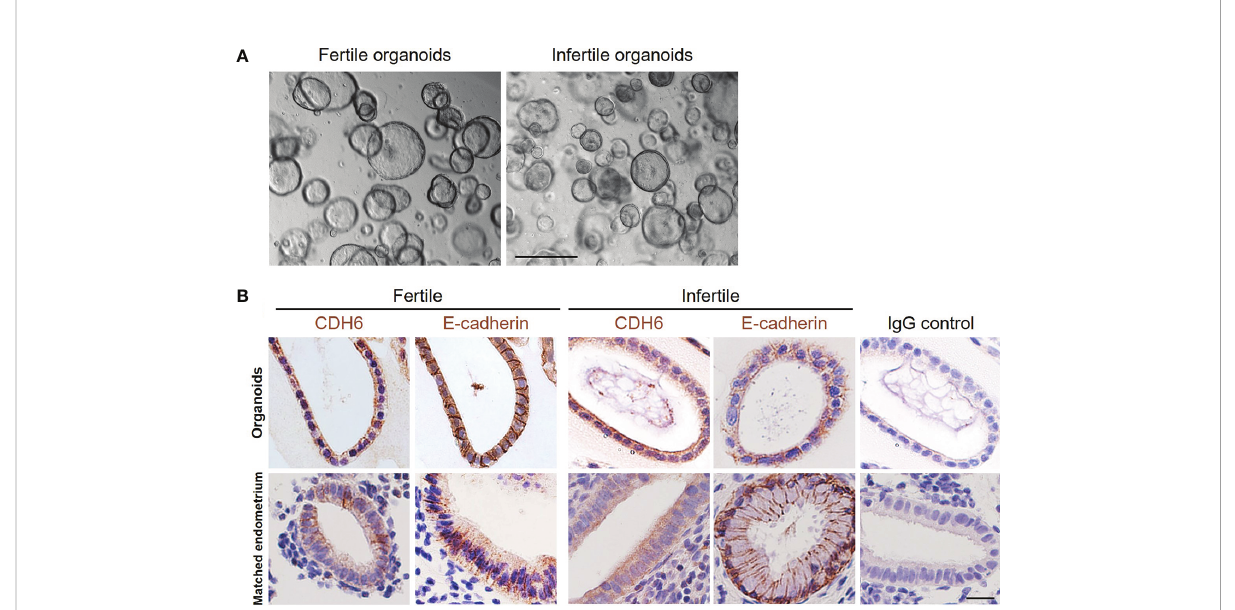
FIGURE 1 Establishment of fertile and infertile human endometrial organoids in vitro . (A) Representative images of fertile and infertile organoids under culture. The scale bar represents 200 m m. (B) The immunolocalization of CDH6 (tight junction marker) and E-cadherin (epithelial marker) was examined in the matched endometrial glands and organoids from the same donor. Similar localizations were recorded for all markers examined. An IgG control was included in which the non-immune antibody of the same isotype (IgG) was substituted for each primary antibody at the same concertation. The scale bar represents 20 m